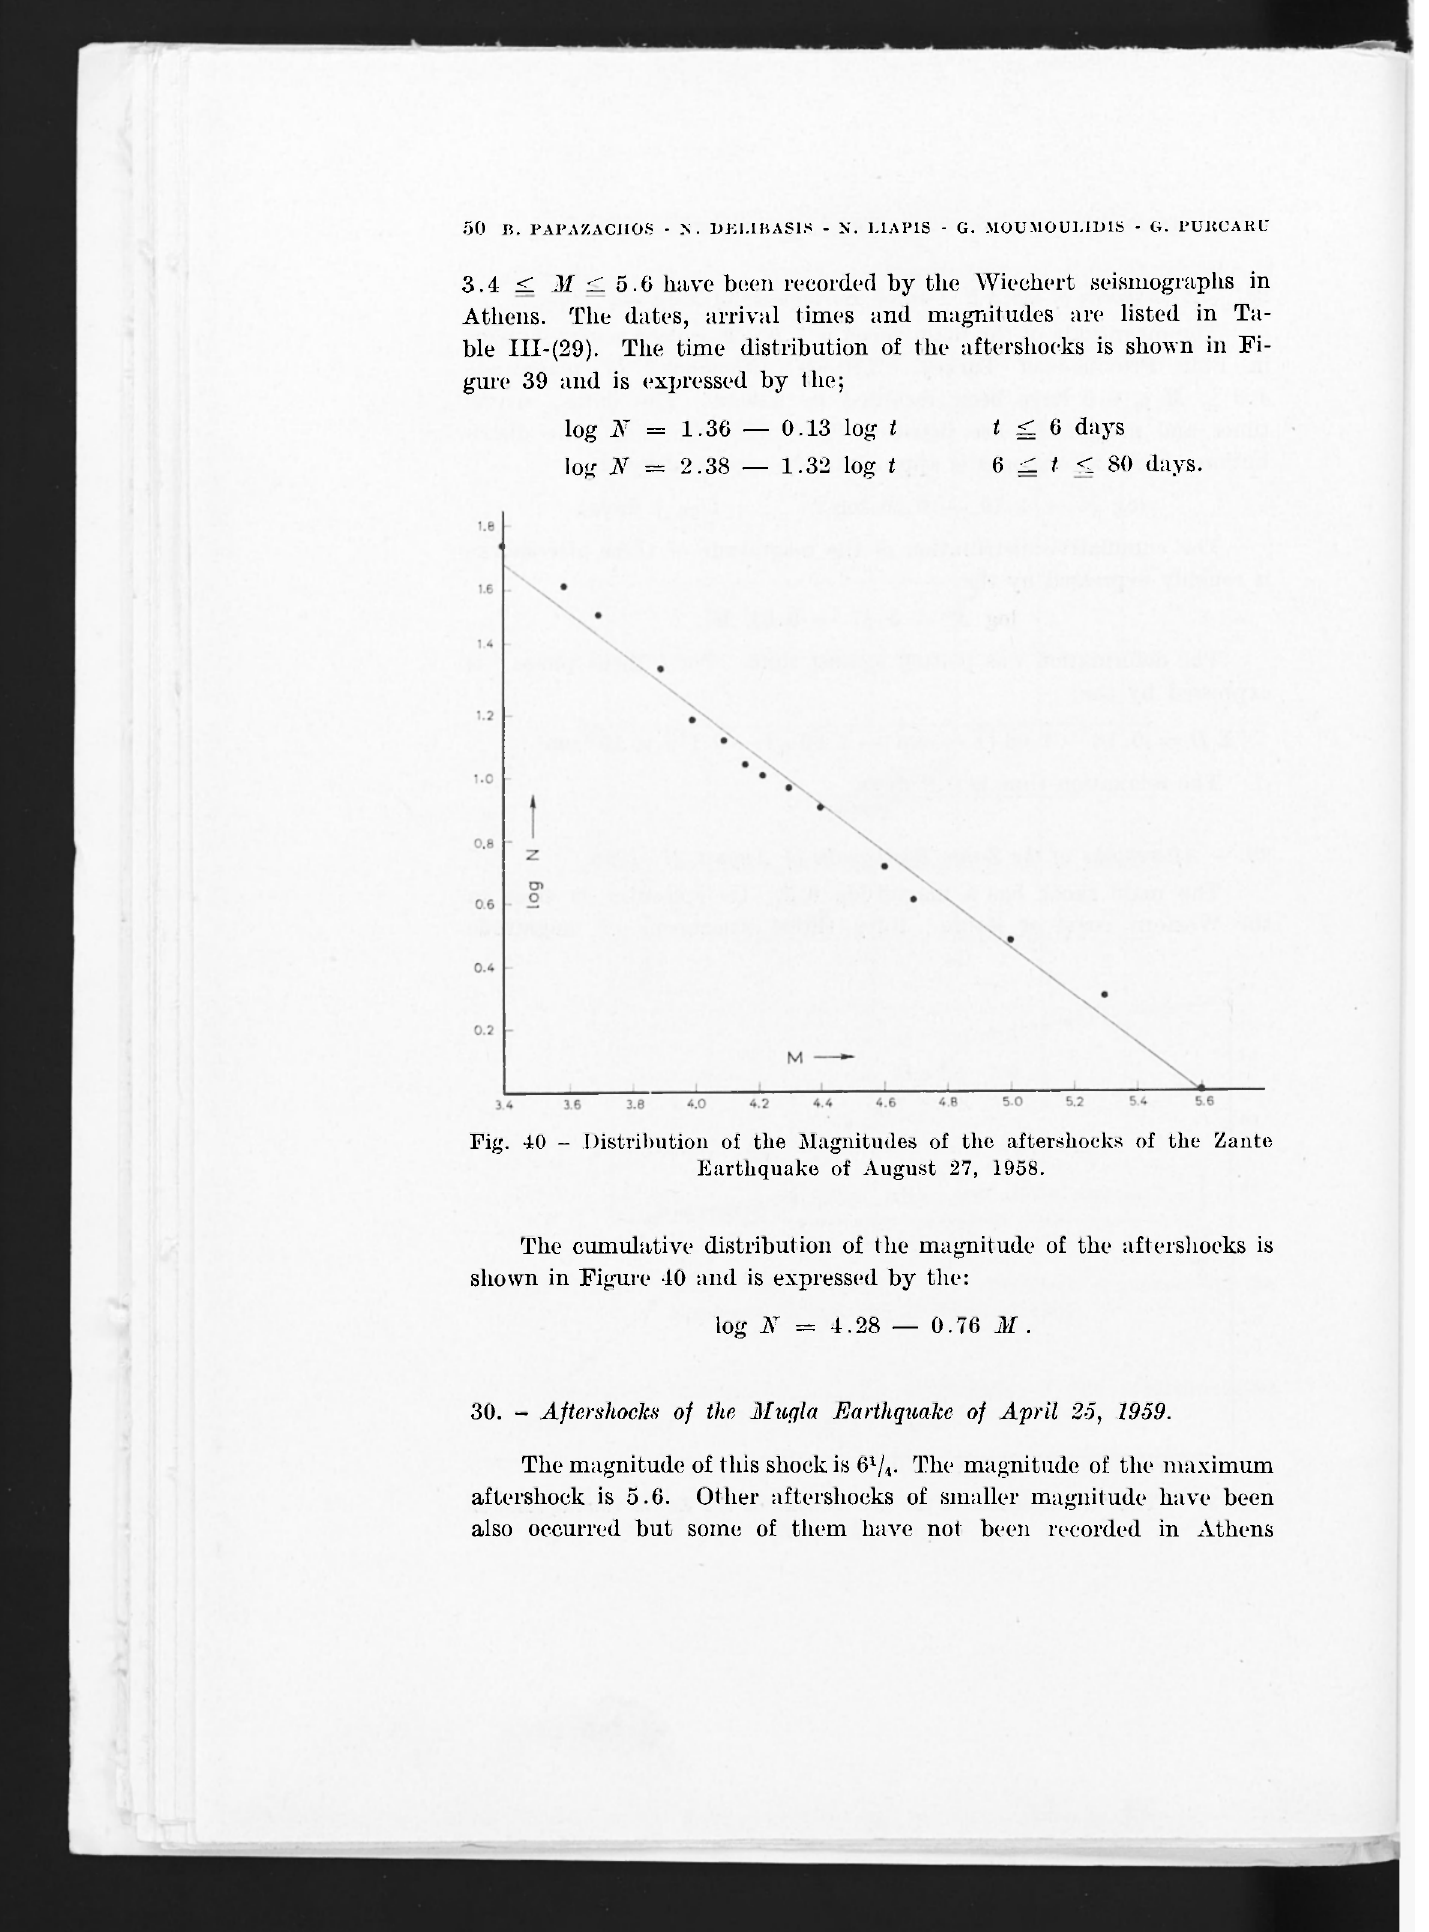
Fig. 40 - Distribution of the Magnitudes of the aftershocks of the Zante Earthquake of August 27,